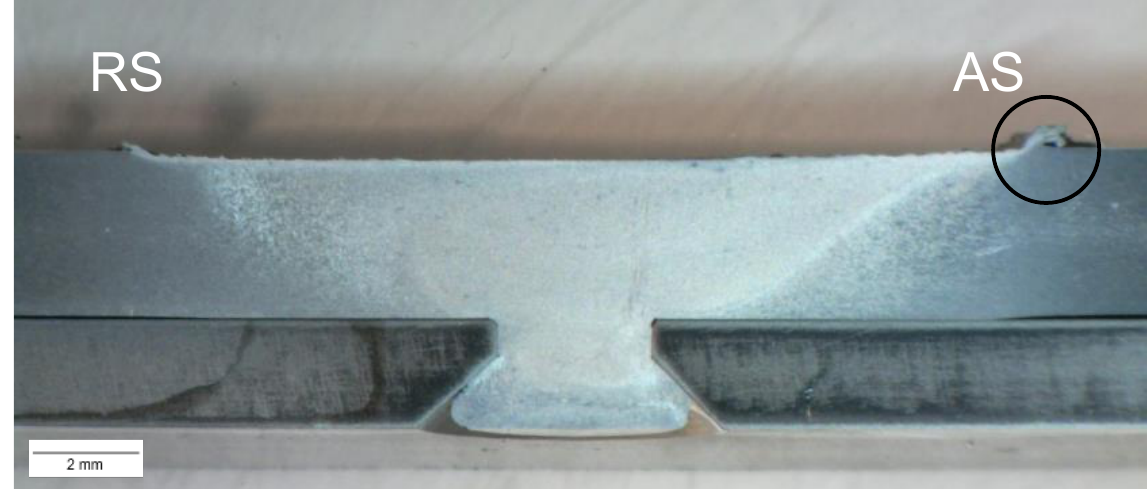
Figure 4. Detailed view of the cross-section of condition E3, in the middle of the created aluminum pin. Generated flash highlighted by the black circle.